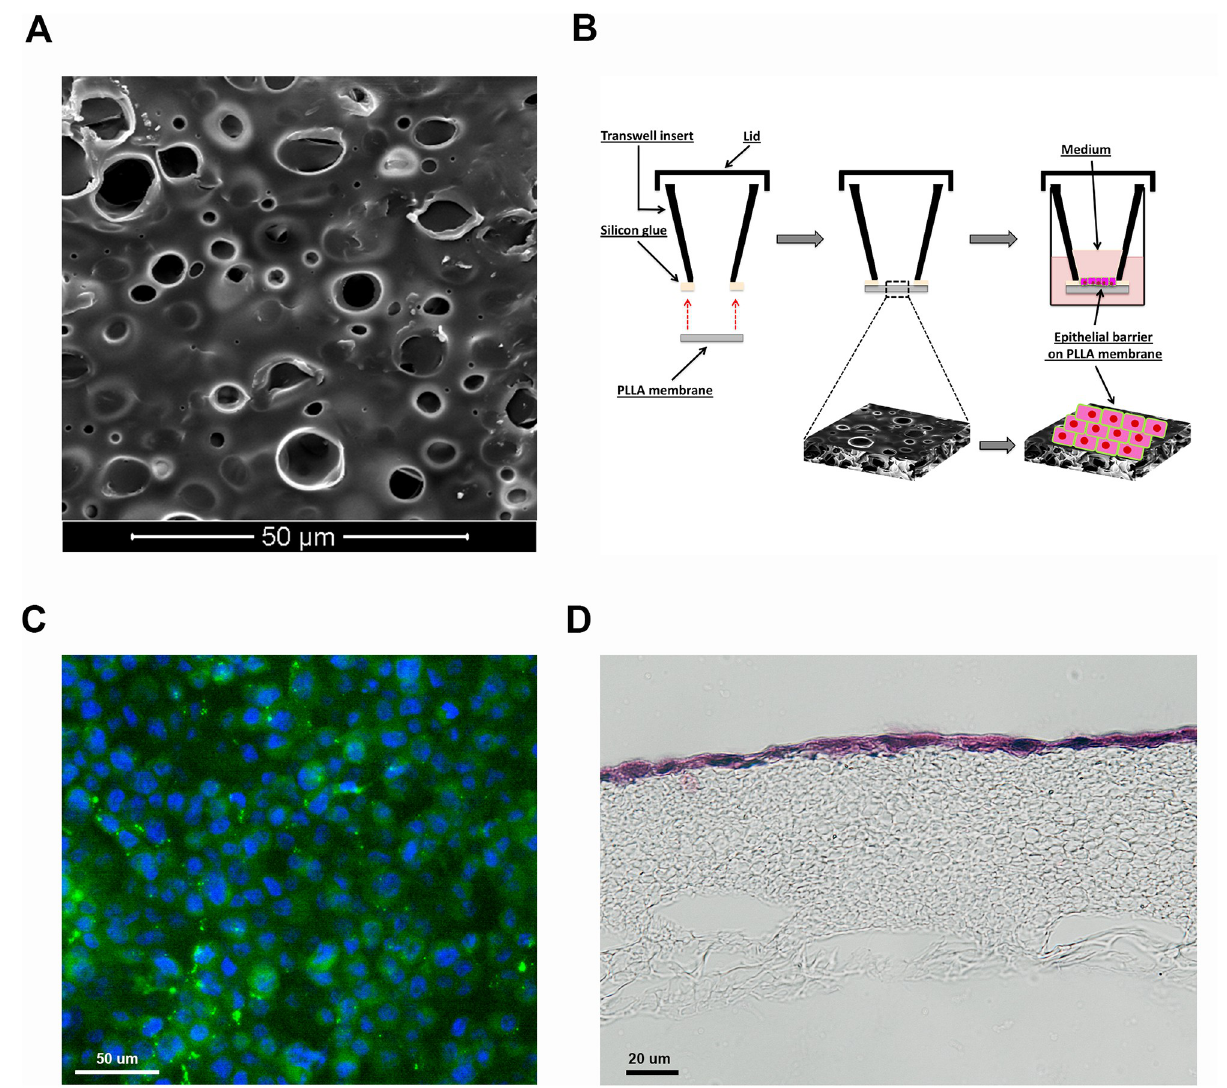
Fig 1. Cell layer formation on PLLA cell culture inserts. A) Morphology of the upper PLLA membrane surface obtained via modification of the standard DIPS method. B) Schematic representation of PLLA cell culture insert. C) An H441 cell monolayer was grown in a PLLA membrane within a cell culture insert and labelled with the fluorescent cell membrane tracker (Blue DAPI and Green Dye-Cell tracker). D) H&E staining of a section of the PLLA membrane covered with an epithelial monolayer after 48 h culture in a cell culture insert.